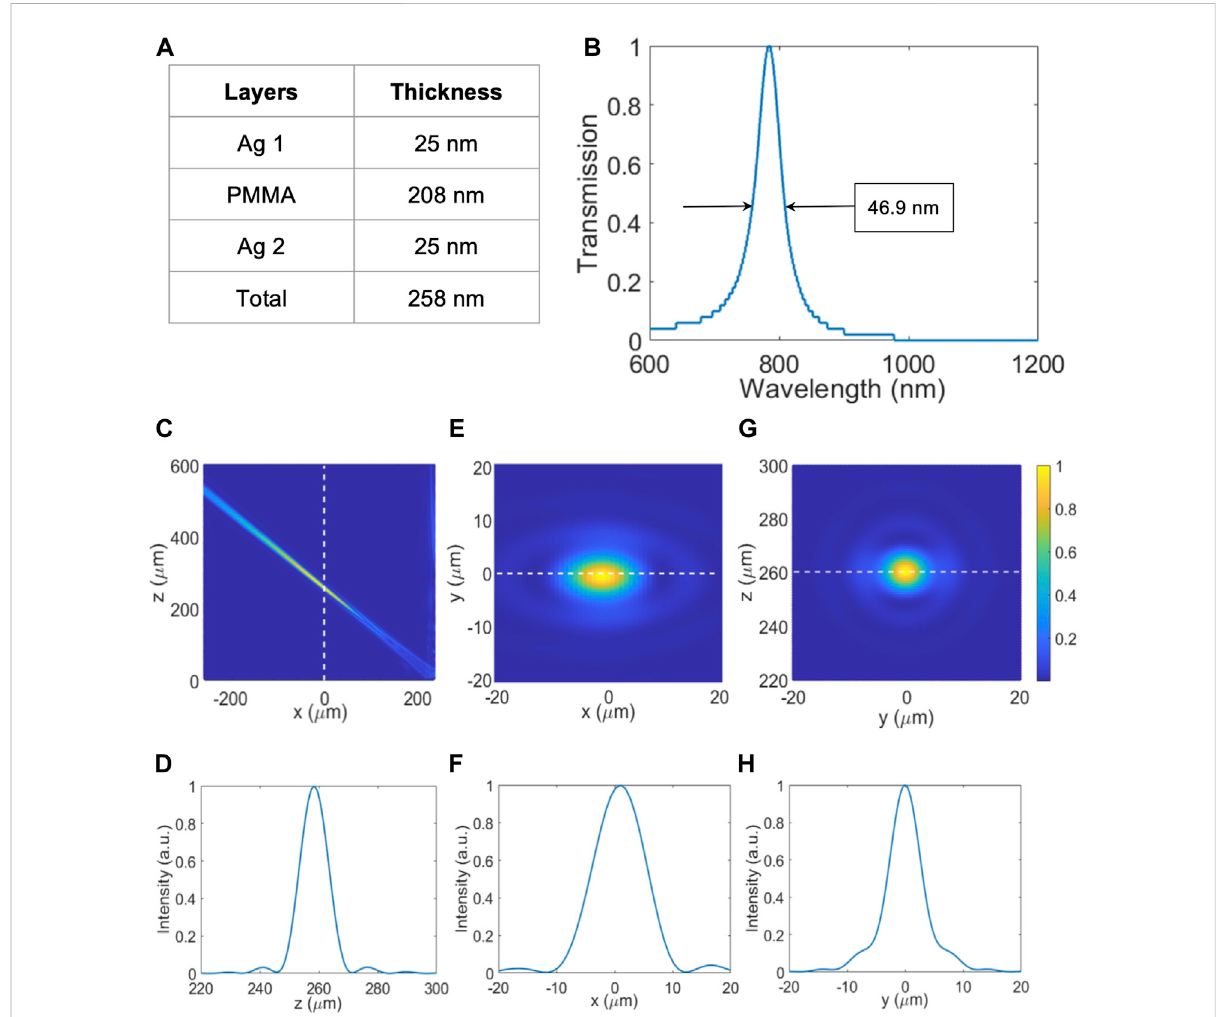
FIGURE 5 Simulation results for 785 nm NBPF and off-axis metalens. (A) Table consolidating the thickness of each NBPF layer and its material. (B) Transmission vs. Wavelength plot of 785 nm NBPF for the range of 600 – 1200 nm with the peak wavelength = 784.4 nm and FWHM = 46.9 nm. (C) Normalizedintensityplotofthefocalpointpro fi leof785 nmoff-axisfocusing onthex-zplane. (D) Normalizedintensityplotofthefocalpointalong the z-axis. (E) Normalized intensity plot of the focal point pro fi le of 785 nm off-axis focusing on the x-y plane. (F) Normalized intensity plot of the focal point along the x-axis. (G) Normalized intensity plot of the focal point pro fi le of 785 nm off-axis focusing on the y-z plane. (H) Normalized intensity plot of the focal point along the